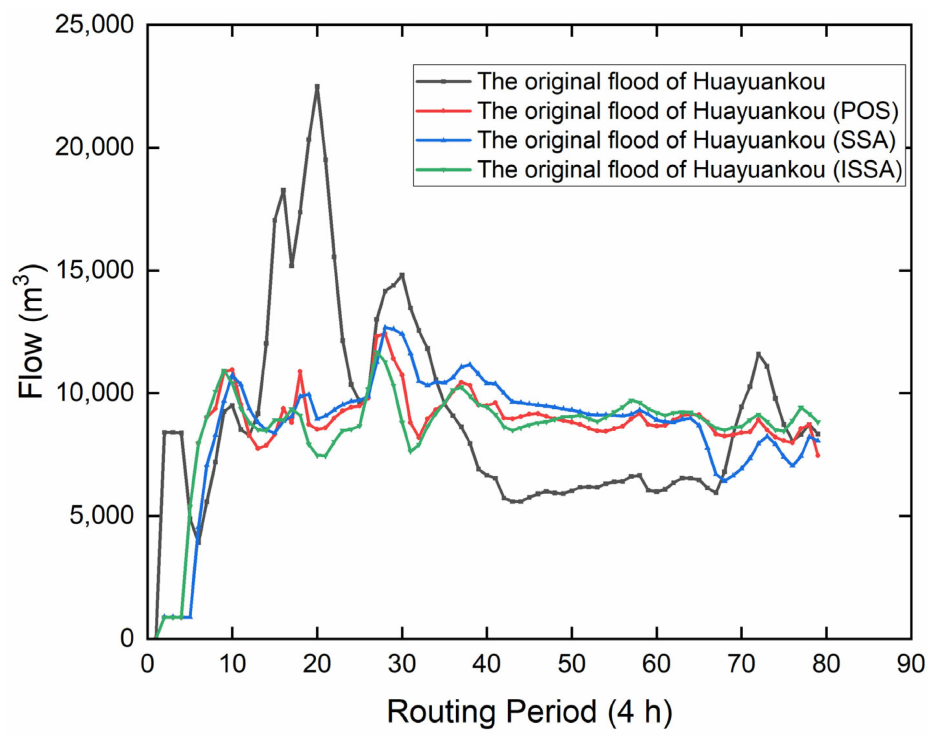
Figure 8. Flood process of Huayuankou control